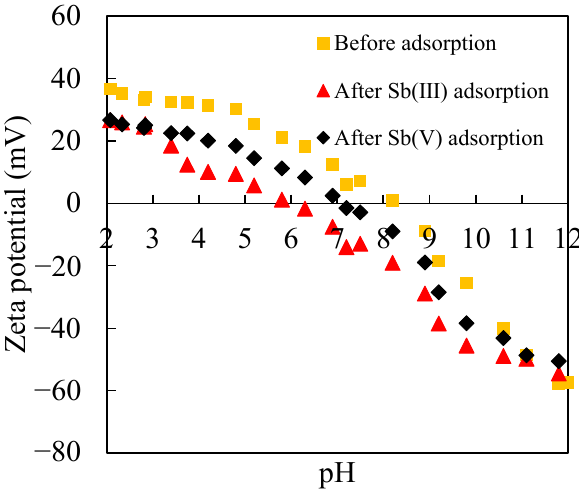
Figure 5. Changes in the ζ -potential of ferrihydrite after adsorbing Sb(III/V) as a function of pH in 0.01 M NaCl. The initial Sb(III/V) concentrations were 100 µM for all samples. The concentrations of suspended solids were 0.5 g/L.